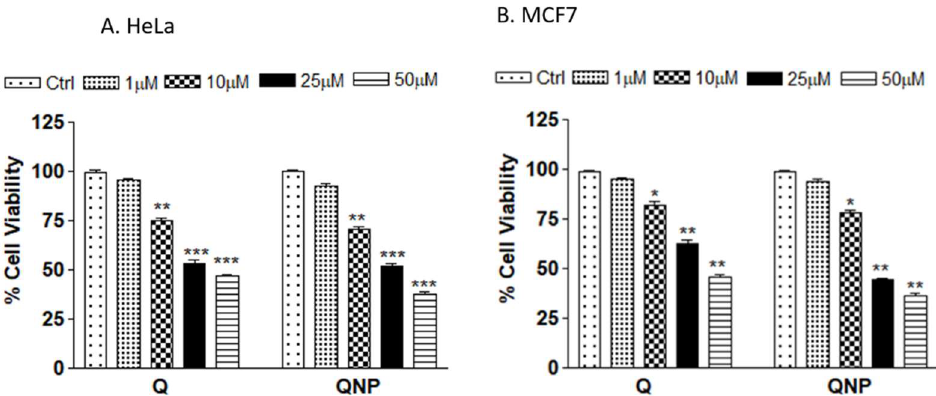
Figure 4. Percent viability of cancer cells treated with different concentrations of Q or QNPs for 24 h, ( A ) Human cervical cancer cell line HeLa; ( B ) MCF-7 breast cancer cell line. * p < 0.05 or ** p < 0.01 or *** p < 0.001 as compared to control.